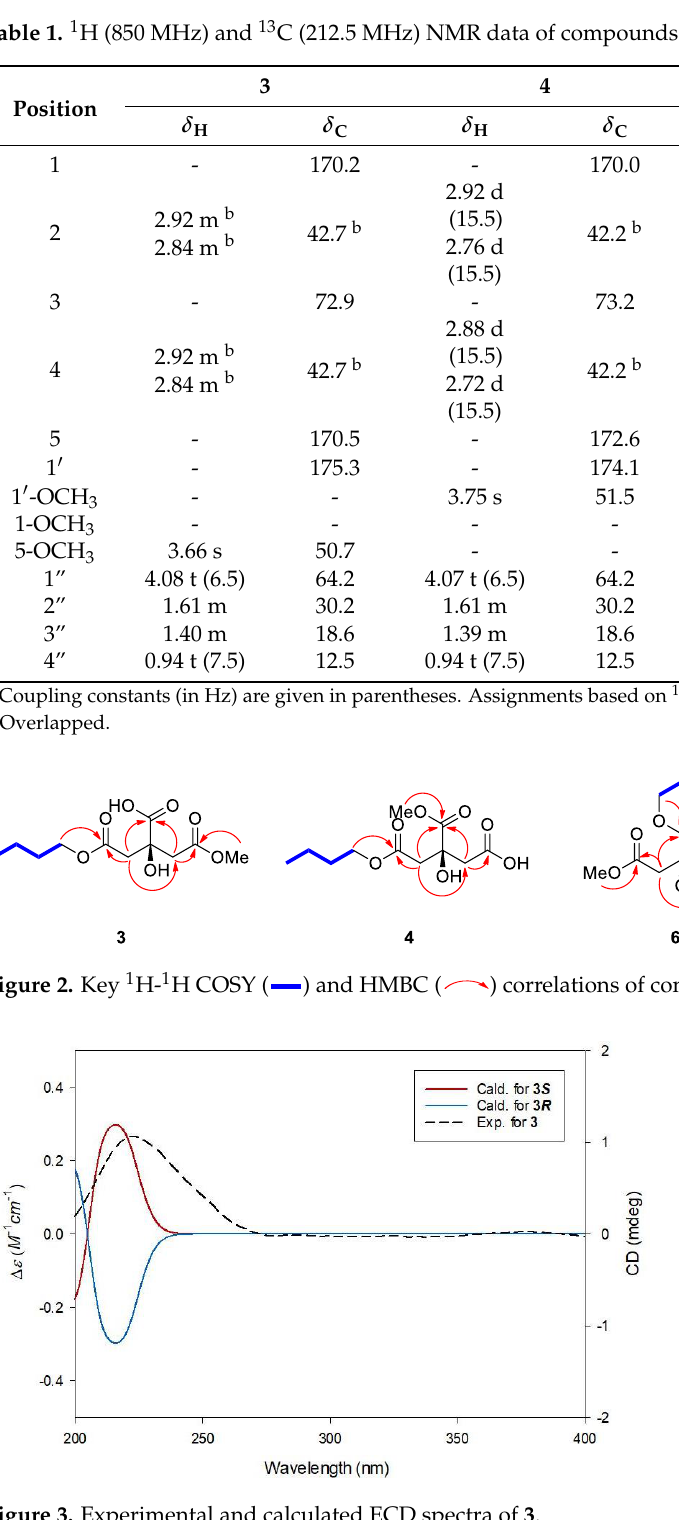
Figure 1. Chemical structure of compounds 1–7 .